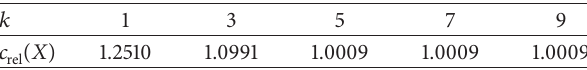
Table 5: Results for Example 4 with different values of 𝑘